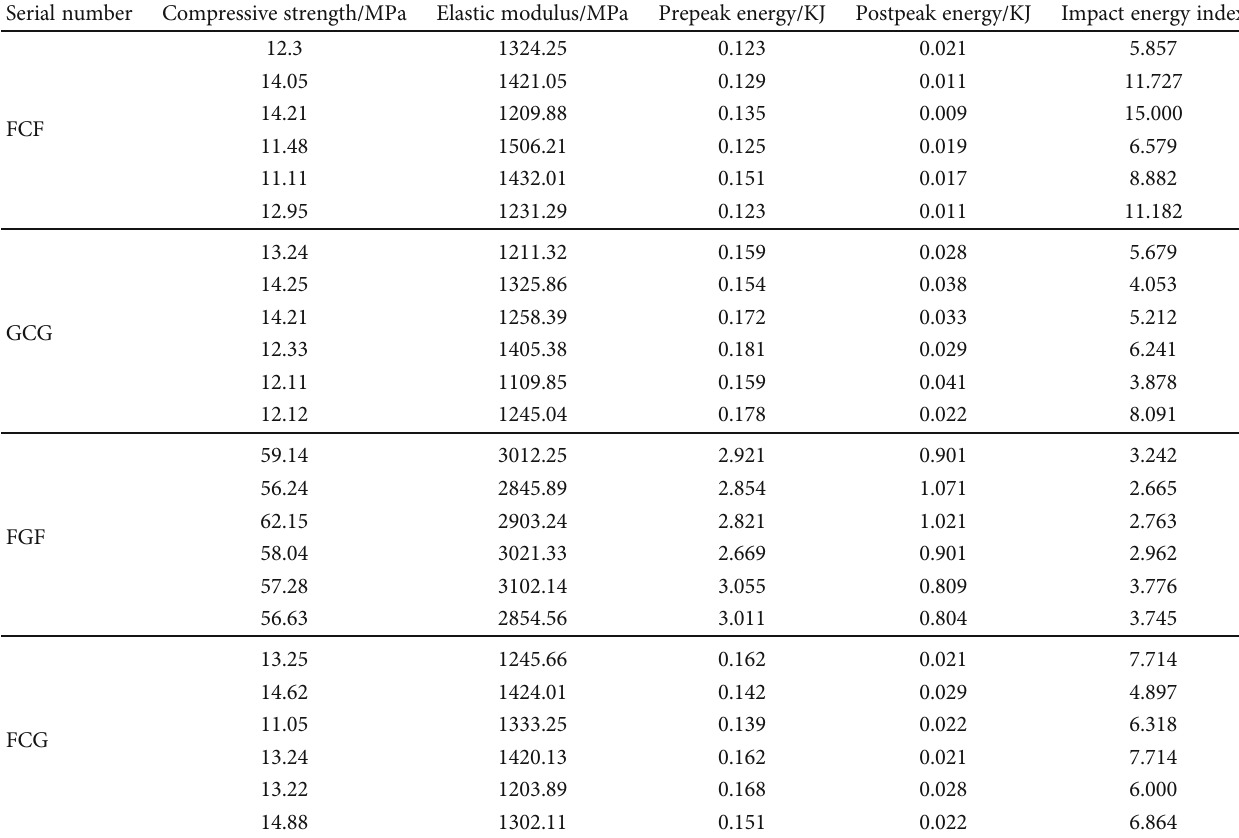
Table 2: The experimental data of each parameter of the combined body.